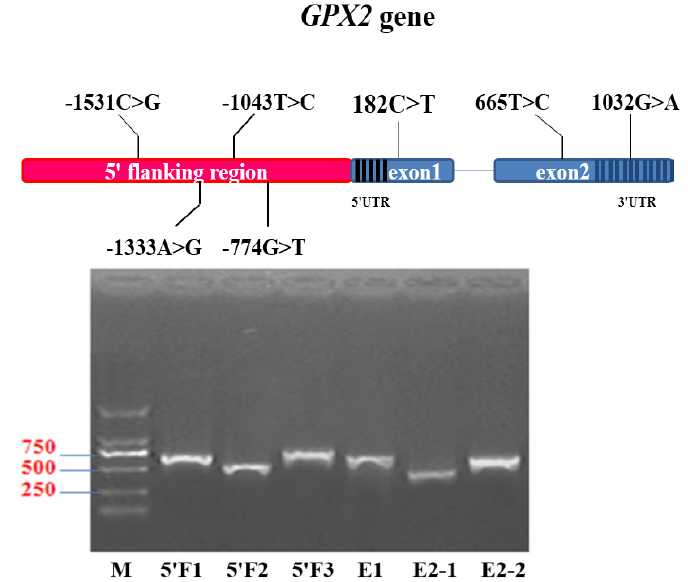
Figure 1. Genetic information for the pig GPX2 gene.